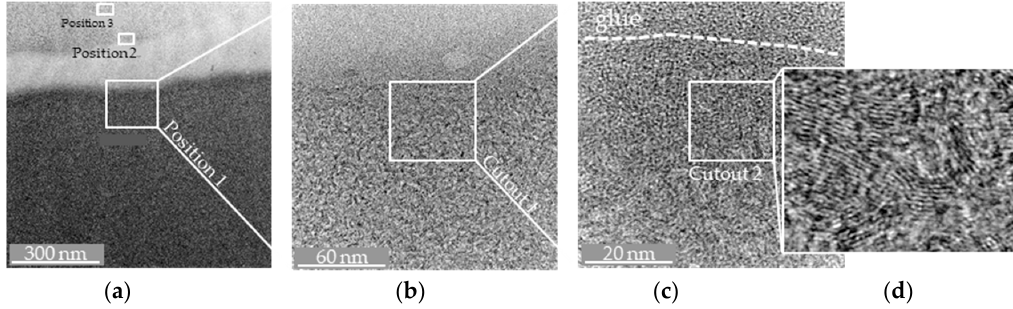
Figure 6. ( a ) Overview on the TEM-measurement area on the wedge-glued Glassy Carbon specimen; ( b ) Magnification at Position 1 ; ( c , d ) Further Magnification of the subsurface region and cut-out of the microstructure.